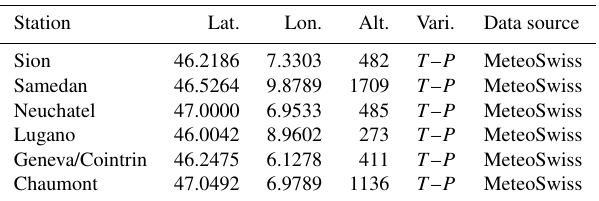
Table A1. Additional climate stations investigated: station name, location (WSG 84), altitude (m), daily resolution time series inves- tigated with temperature ( T ) and precipitation ( P ) and data source Federal Office of Meteorology and Climatology of Switzerland